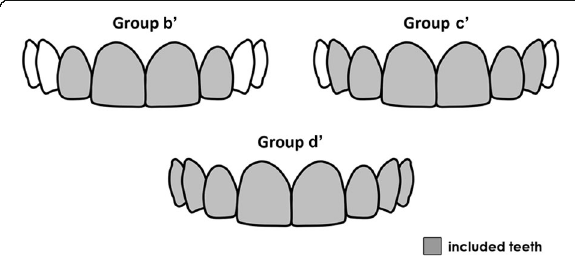
Fig. 6 Groups for superimposing the 3D dataset of the anterior teeth in experiment 2. Labial surfaces from the right to the left second incisor ( b ′ ), the right to the left canine ( c ′ ), and the right to the left first premolar ( d ′ )